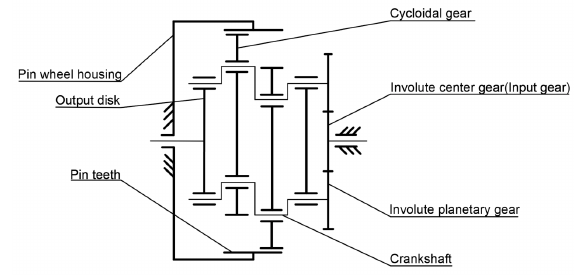
Figure 1. The RV transmission